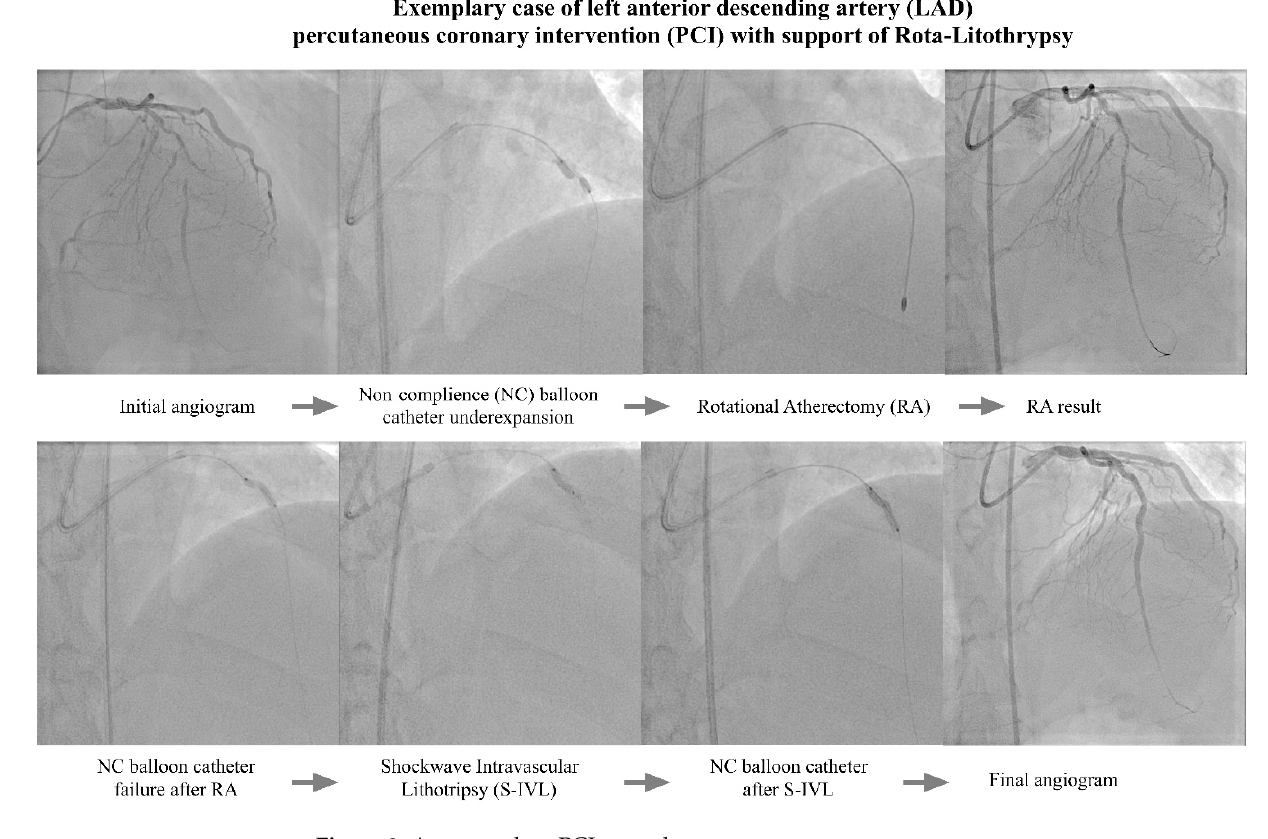
Figure 2. An exemplary PCI procedure.